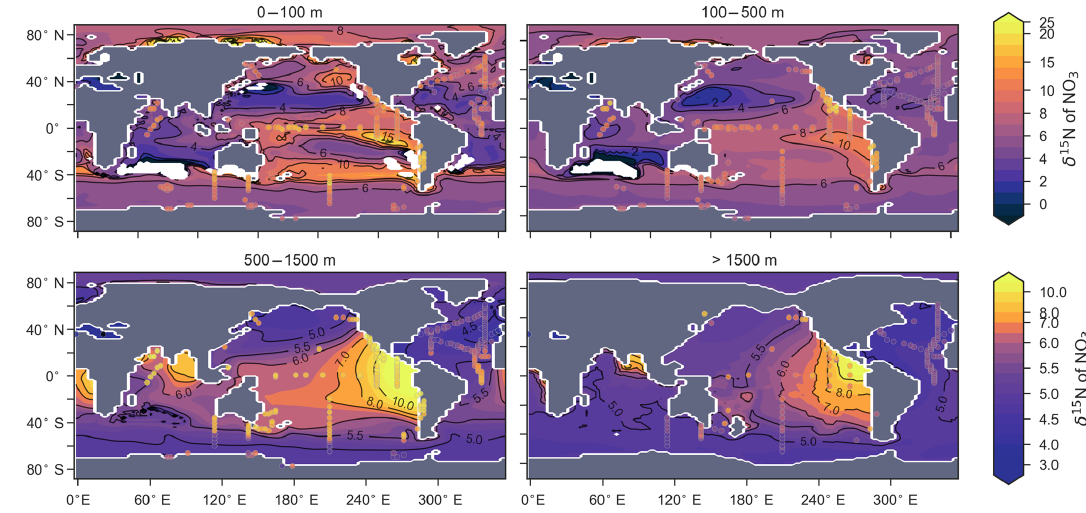
Figure 8. Depth-averaged sections of modelled (colour contours) and observed (overlaid markers) δ 15 N NO